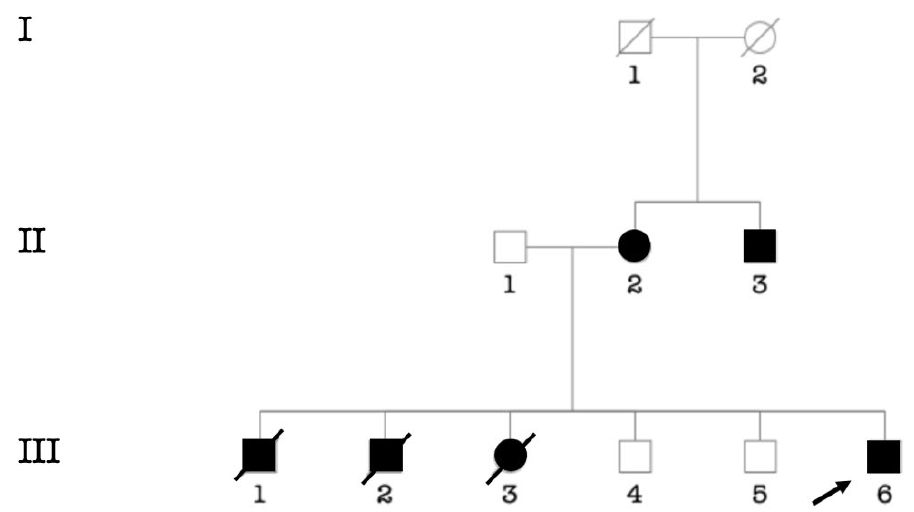
Figure 9. Pedigree showing six affected individuals segregating likely Alport syndrome. The arrow indicates the proband.